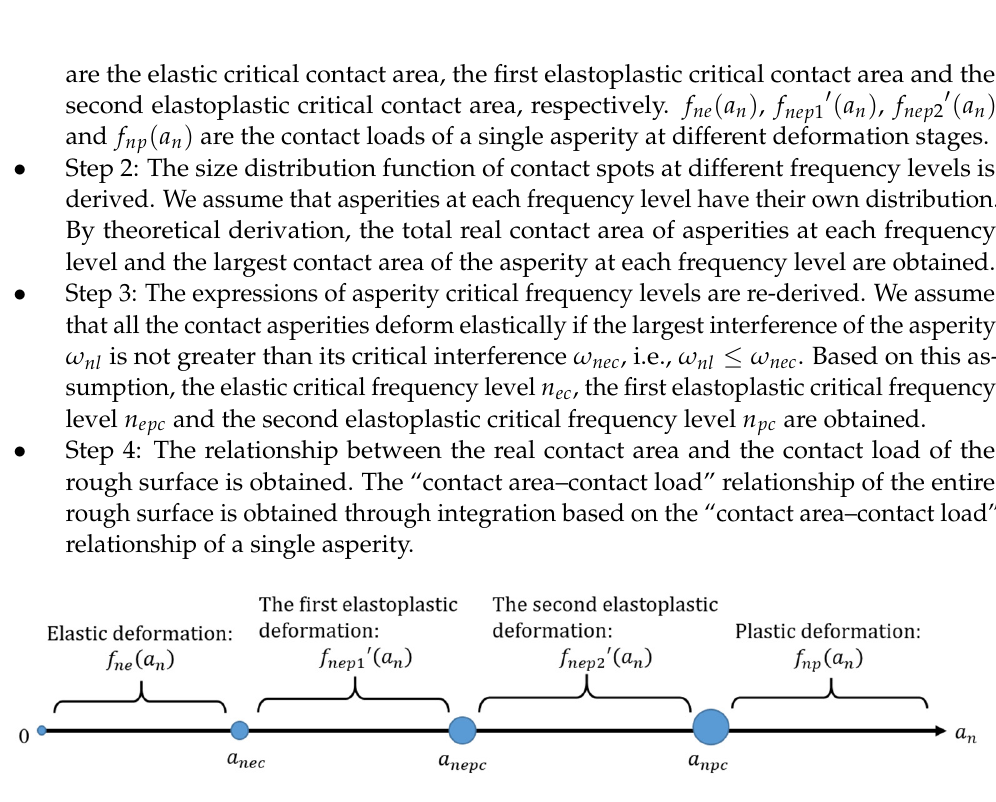
7 of 29 Figure 4. Examples of surface topography of the real surfaces: ( a ) turning; ( b ) grinding. 2.2. Contact Model of Rough Surface Engineering materials are known to have rough surfaces that lead to roughness. The full control of surface topography at all scales during manufacturing processes is still out of reach [10]. In order to obtain the intrinsic parameters of the porous medium space, it is necessary to establish the contact model of the two rough sealing surfaces. In our recently published research paper [43], a contact model for rough surfaces based on fractal theory is proposed. The proposed model, whose feasibility and credibility are verified by comparison with other contact models and experimental data, is a modifi-